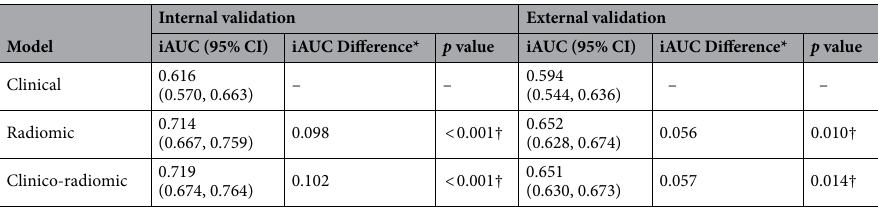
Table 3. Model performances measured by iAUC for prediction of recurrence-free survival. iAUC, the integrated area under the receiver operating characteristic curve; CI, confidence interval. *Comparison with clinical model. † Statistically